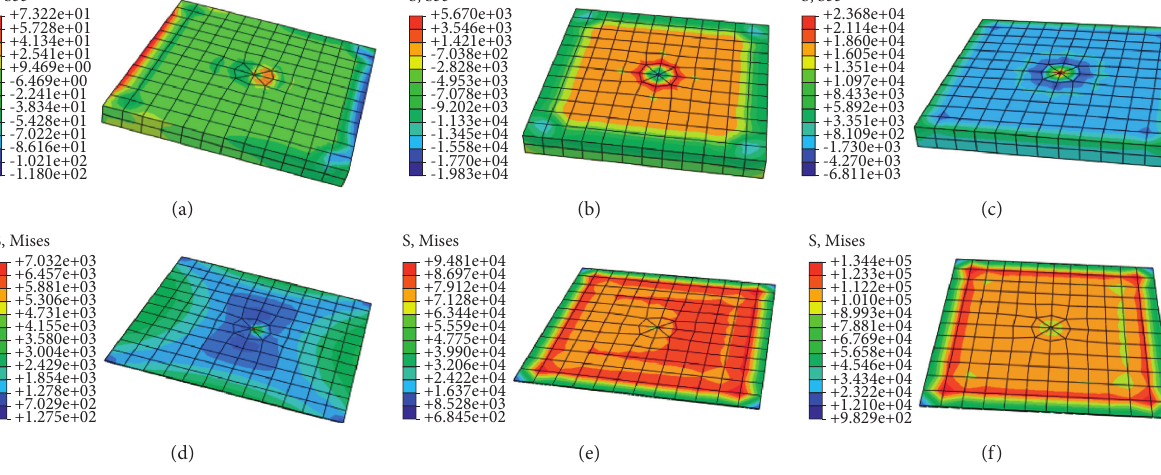
Figure 21: Normal bond stress distribution of the semirigid finish layer (unit: MPa). (a) Insulation layer (without temperature). (b) Insulation layer (50 ° C). (c) Insulation layer (–20 ° C). (d) Interface layer (without temperature). (e) Interface layer (50 ° C). (f) Interface layer ( − 20 °